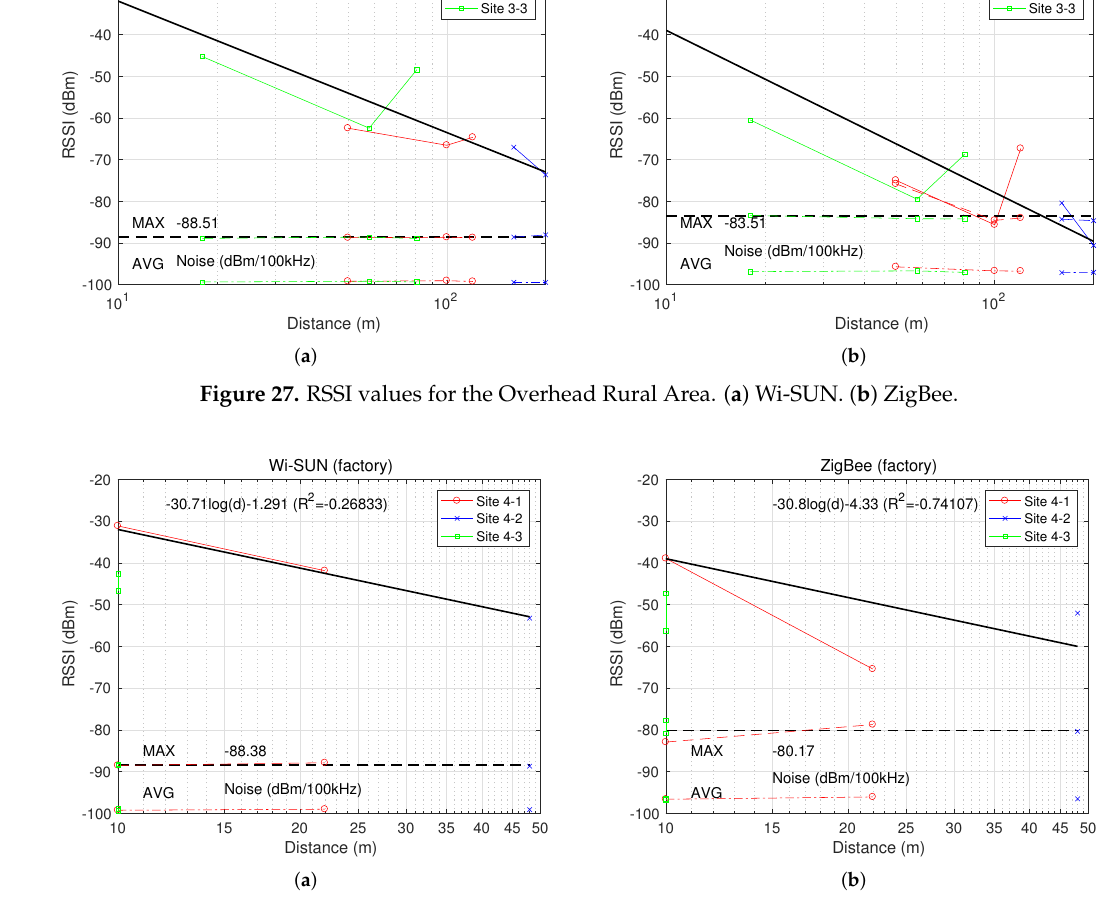
Figure 28. RSSI values for the Overhead Factory Area. ( a ) Wi-SUN. ( b ) ZigBee.